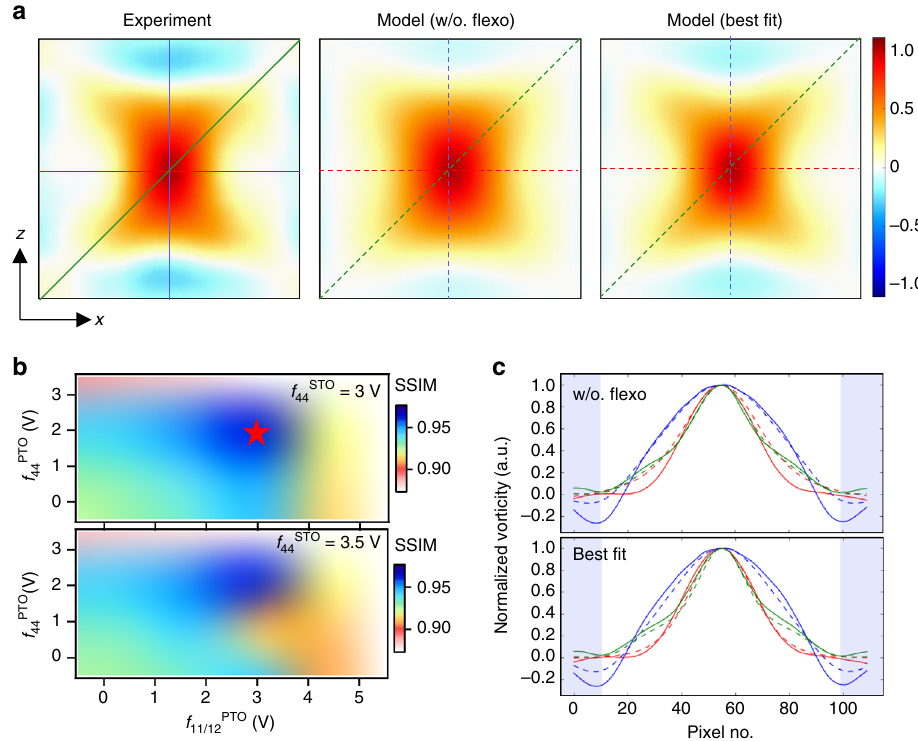
Fig. 4 Matching the observed and simulated vortex patterns. a The fi rst principal components of the observed and simulated (under zero and best- fi t fl exocoupling conditions) vortex patterns. The core vorticity value is normalized to unity in all cases. b Calculated SSIM indices for part of the simulated model library. The value of the white region is typically below 0.8. The star denotes the highest global SSIM index indicting the best- fi t fl exoelectric coef fi cients with the experimental observations. c Section pro fi les of the experimental (solid line) and simulated (dashed line) vorticity along the x , z , and xz -diagonal directions as marked and color coded in a . The lightly blue-shaded region corresponds to STO regions, which is excluded for the SSIM calculation. The pixel size is 45